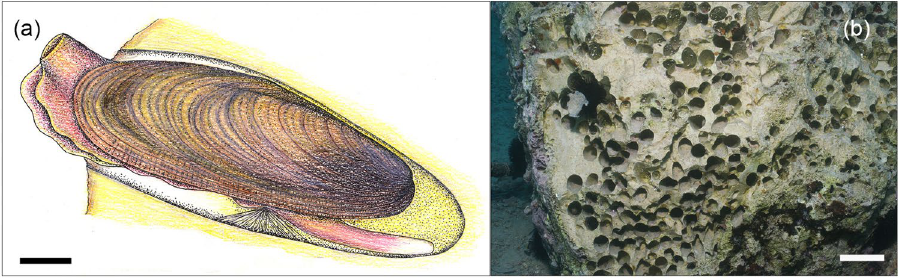
Figure 1. The European date mussel Lithophaga lithophaga . ( a ) An illustration of a living individual within its borehole. ( b ) Empty holes after date mussel harvesting indicate population density. Scale bars: ( a ) 1 cm; ( b ) 5 cm.